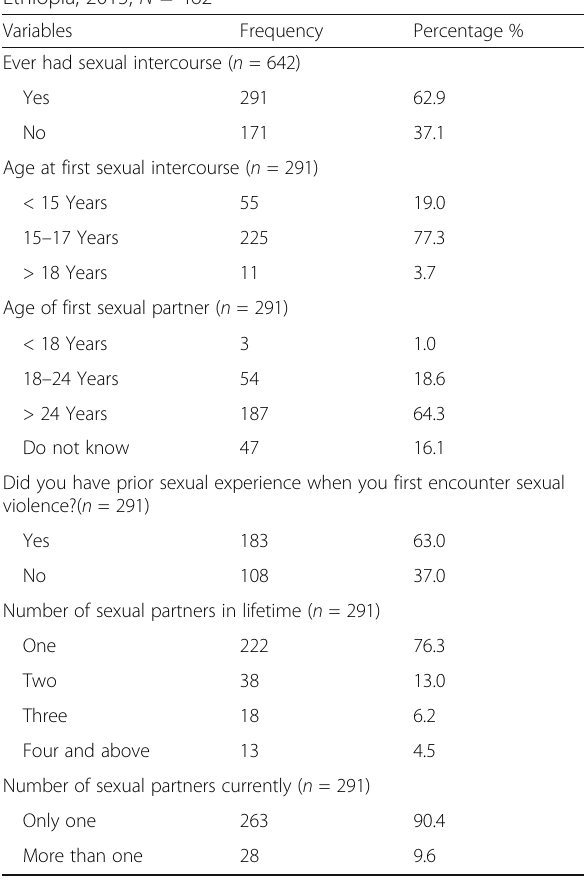
Table 1 Socio-demographic characteristics of Wolaita Sodo Table 2 Sexual experiences of Wolaita Sodo University students, Ethiopia, 2015, N =